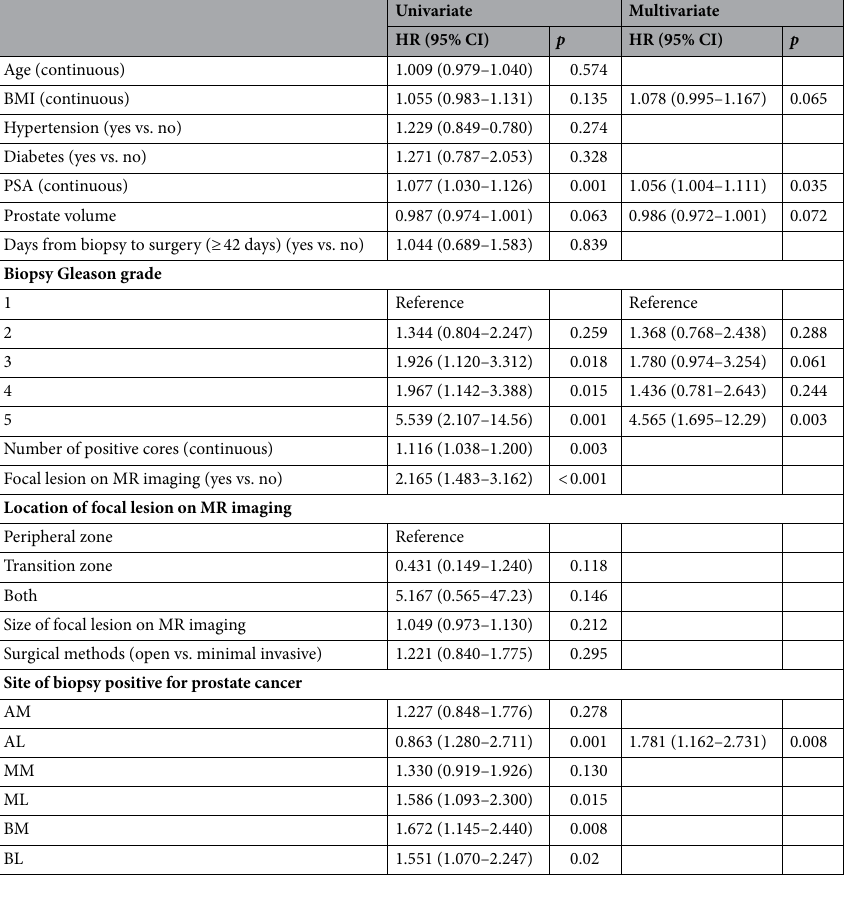
Table 4. Variables associated with surgical margin positivity. AM apical medial, AL apical lateral, MM middle medial, ML middle lateral, BM basal medial, BL basal lateral, NSM negative surgical margin, PSM positive surgical margin.